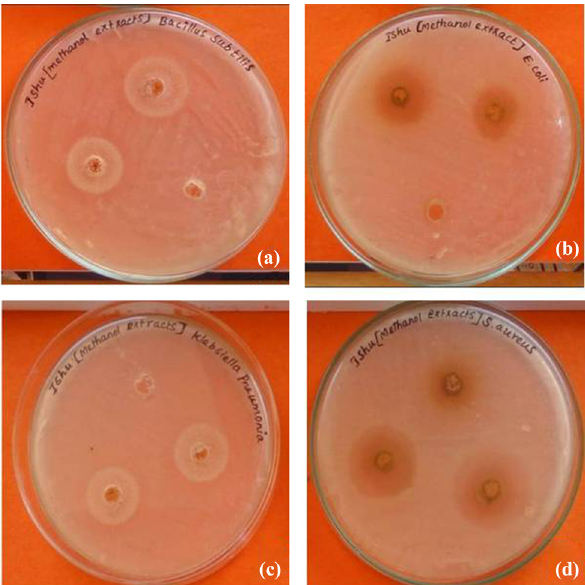
Figure 6: Antimicrobial activity of methanolic extract of D. viscosa : ( a ) B. subtilis , ( b ) E. coli , ( c ) K. pneumoniae , and ( d ) S. aureus